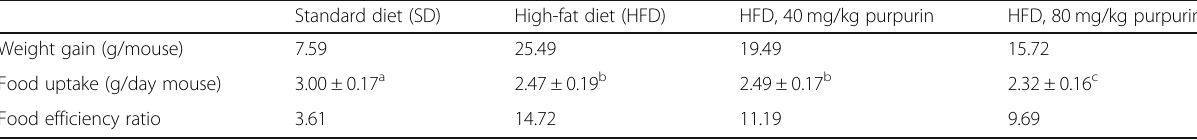
Table 1 Effect of purpurin on weight gain, food uptake, and food efficiency ratio